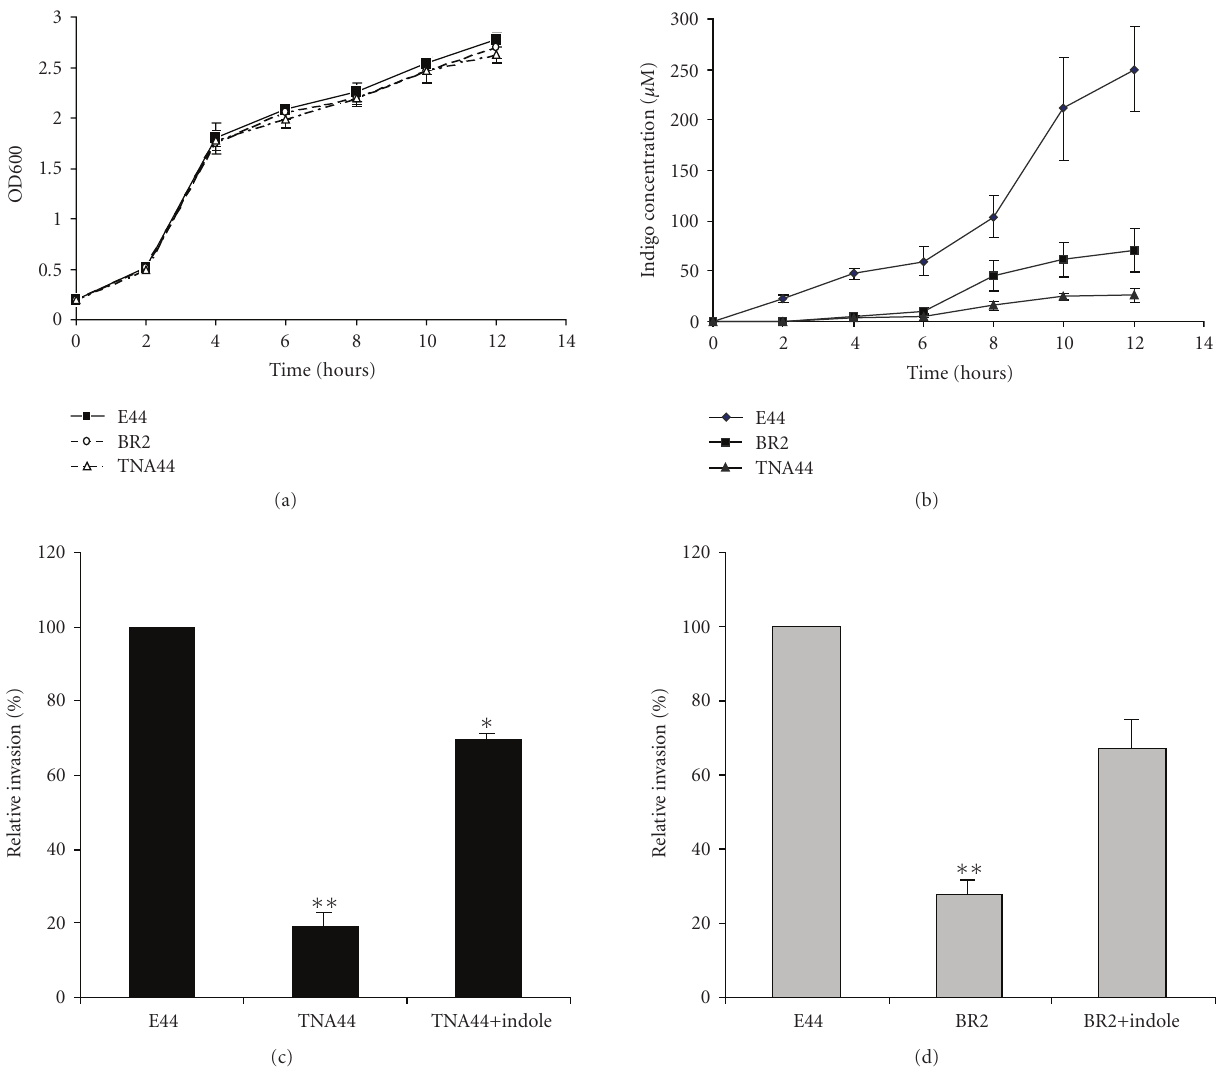
Figure 4: Role of TnaA in indole production and bacterial invasion . (a) Growth curves of E44, TNA44, and BR2, (b) indole production (IP) of E coli strains E44, BR2, and TNA44, (c) the invasion phenotypes of E44, TNA44, and indole(100 μ M)-complemented mutant TNA44, and (d) the invasion phenotypes of E44, BR2, and indole(100 μ M)-complemented mutant BR2. Columns marked with ∗ are significantly di ff erent ( P < . 05), ∗∗ are significantly di ff erent ( P < . 01).